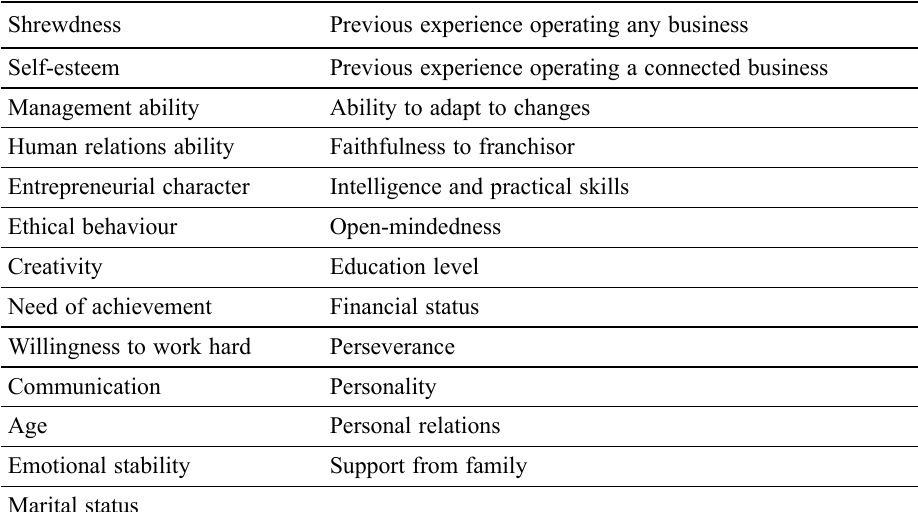
Table 2. Characteristics analyzed of the franchisee profile, according to the review of literature Shrewdness